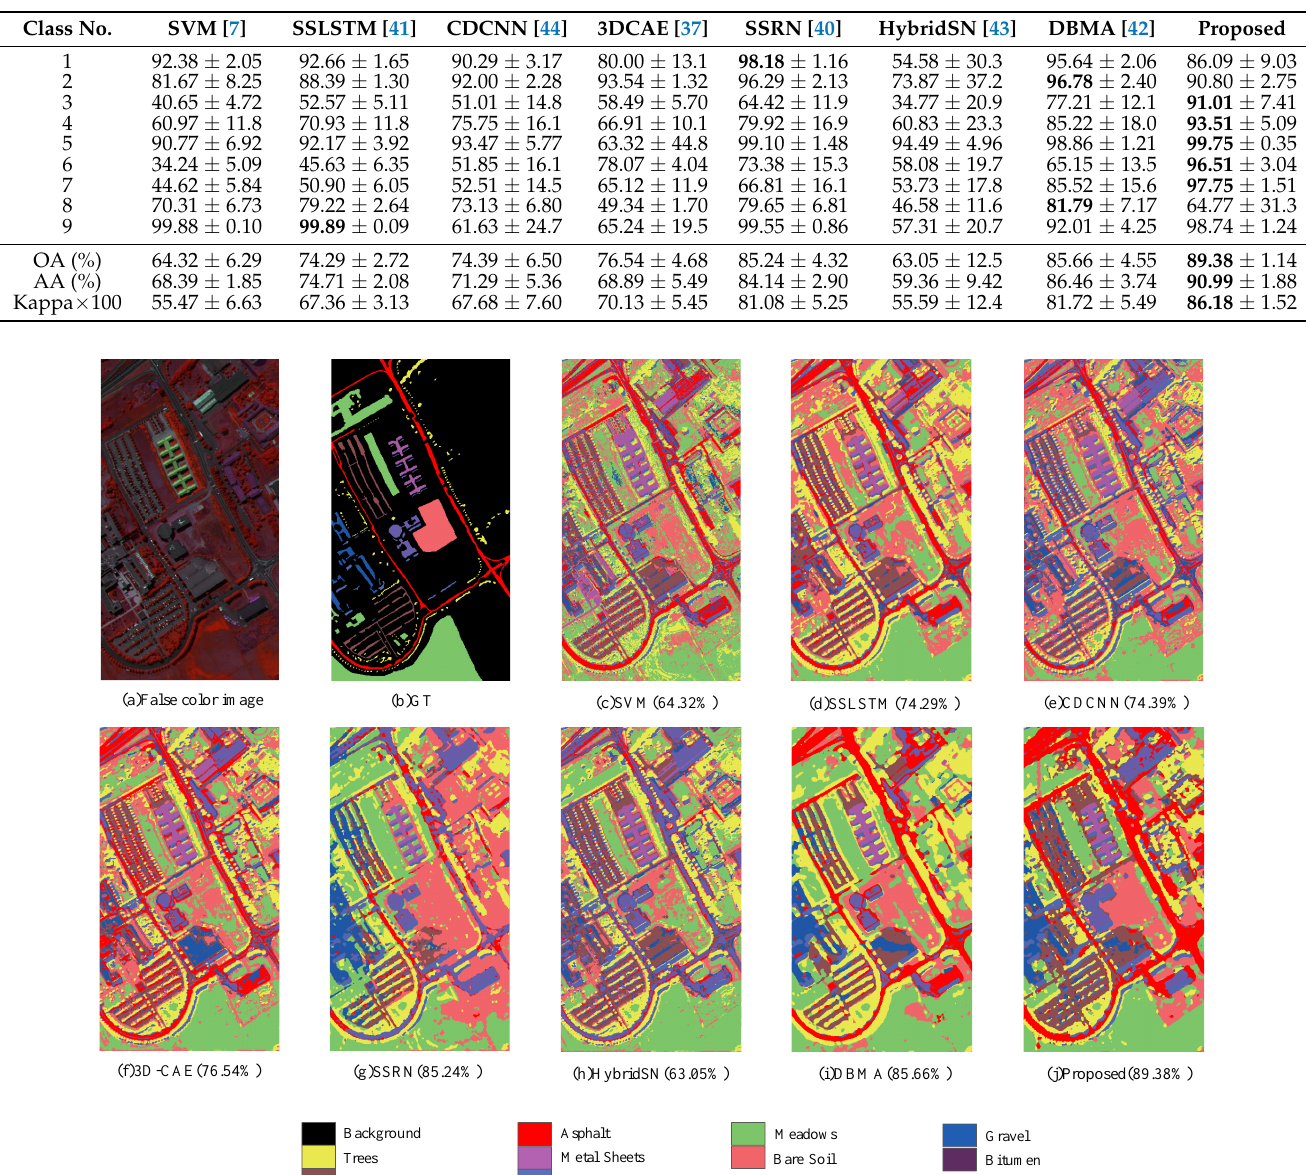
Table 6. Classification results on the University of Pavia dataset with 10 labeled samples, including OA (%), AA (%) and Kappa × 100 in which the best results are denoted in bold.